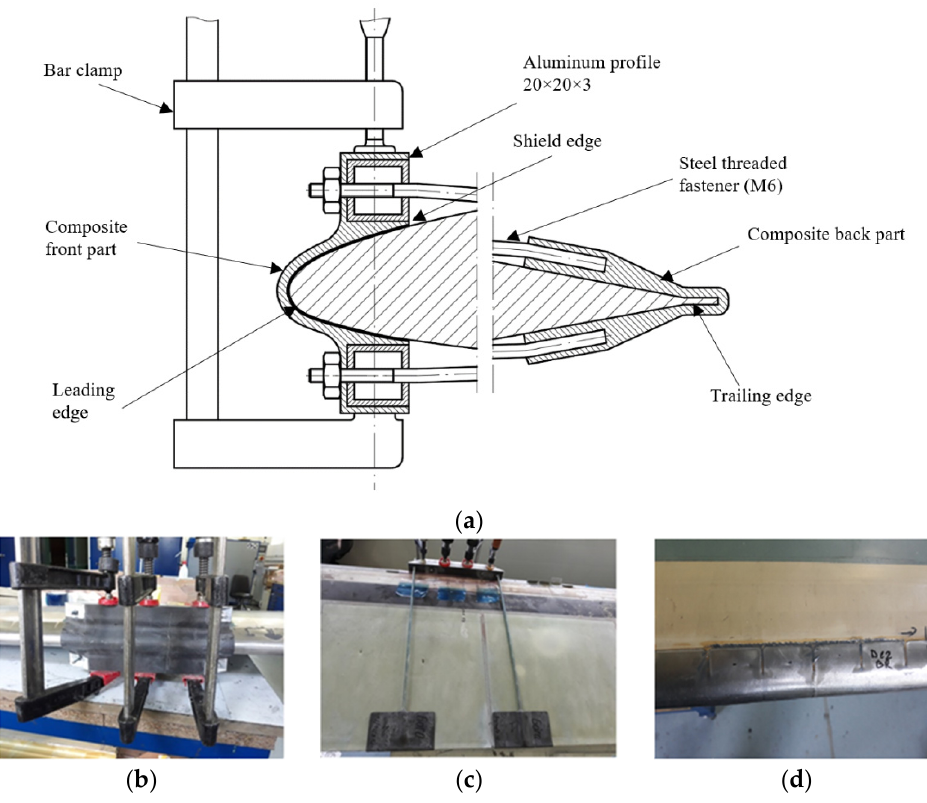
Figure 9. Bonding process: ( a ) Assembly tool—scheme; ( b ) Assembly tool—front; ( c ) Assembly tool—top/back; ( d ) Leading edge after